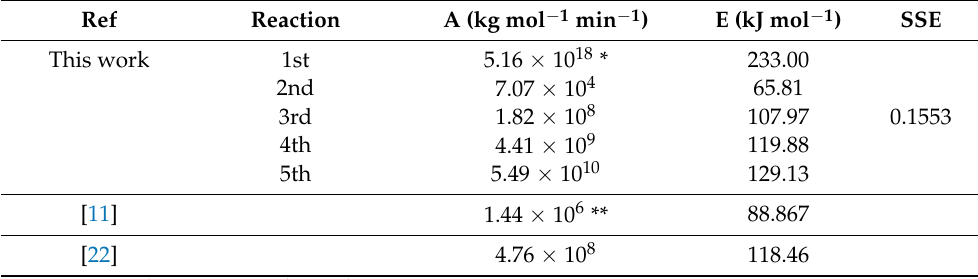
Table 1. Kinetics parameters of esterification of rosin and pentaerythritol.